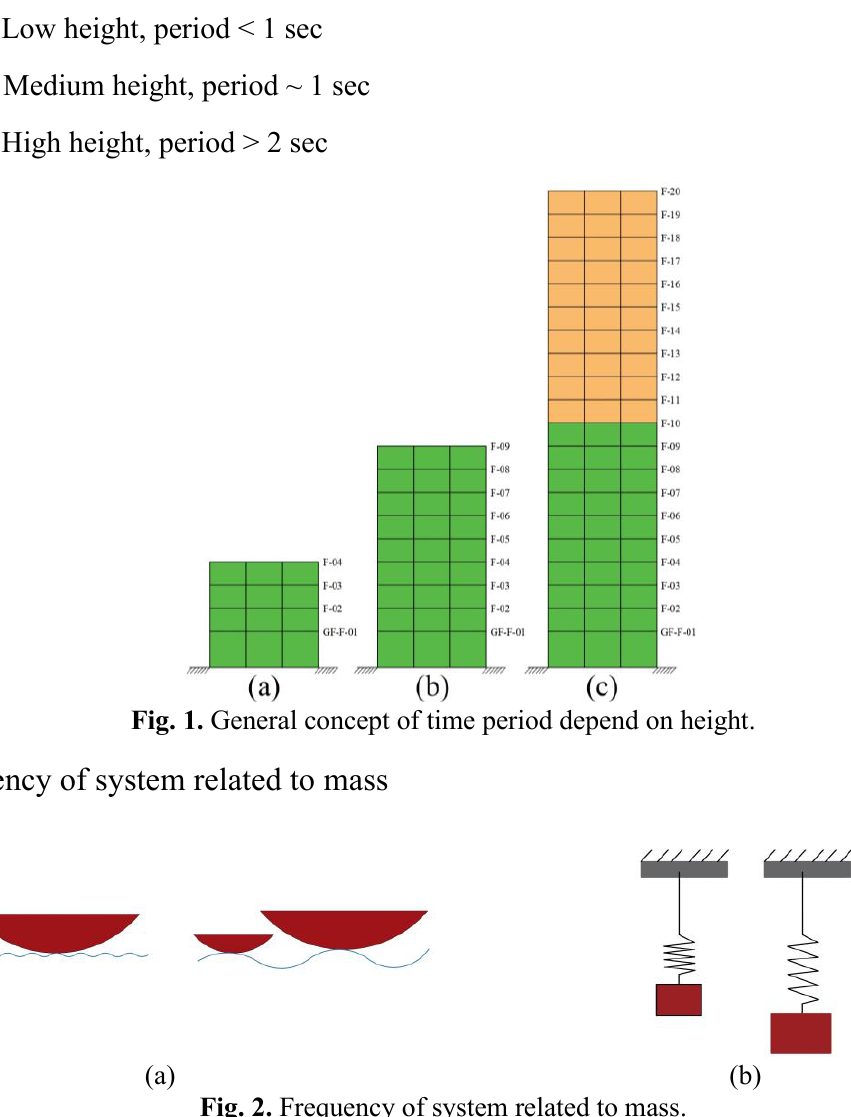
Fig. 2. Frequency of system related to